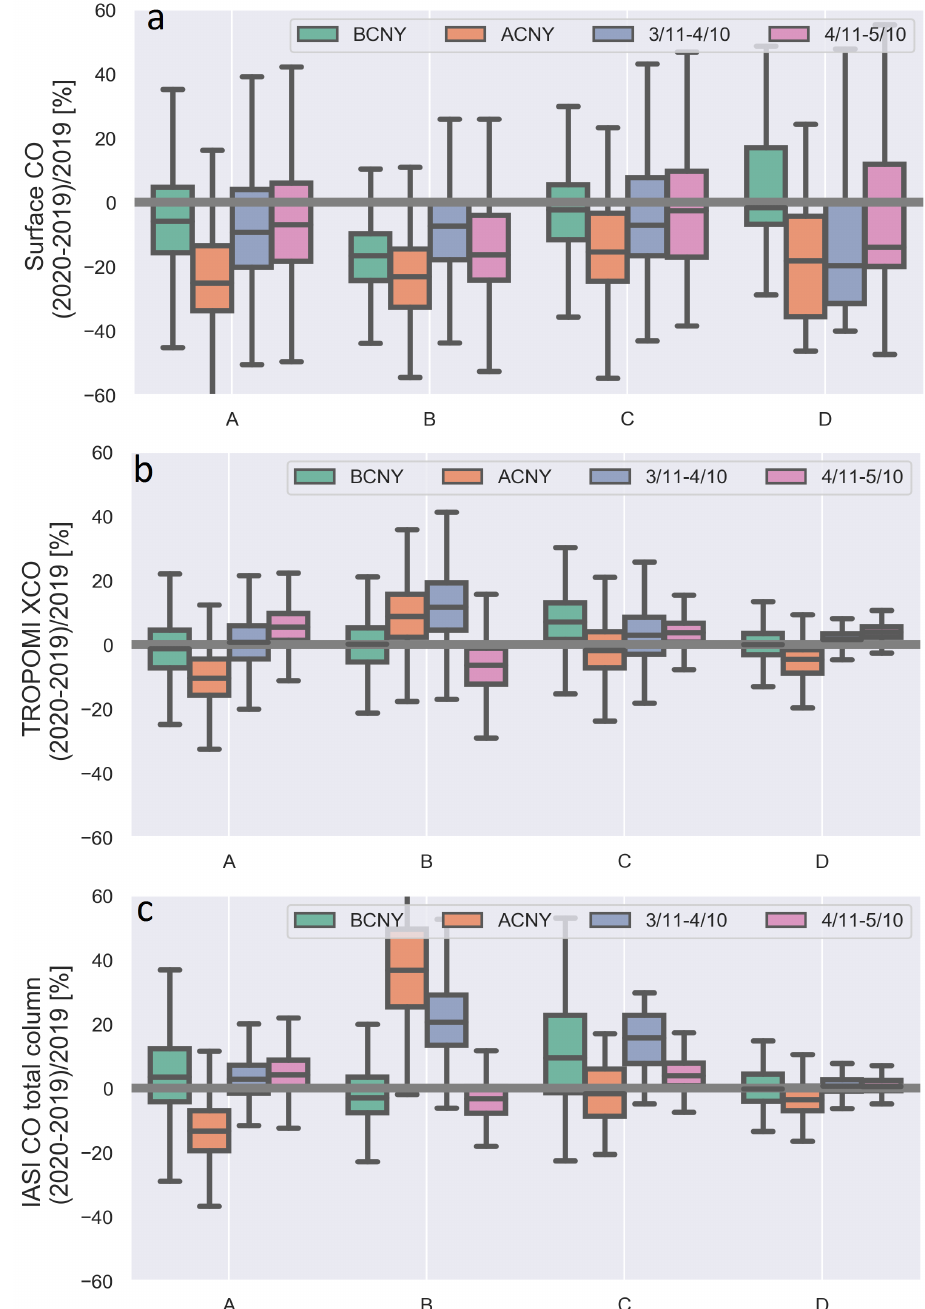
Figure 6. Box plots of the CO changes from the surface ( a ), TROPOMI ( b ), and IASI observations ( c ) during 4 periods in 2020 against those in 2019. Each box plot shows the values of relative difference for the maximum (top of solid line), 75th percentile (top of box), median (line through middle of box), 25th percentile (bottom of box) and minimum (bottom of solid line) of the